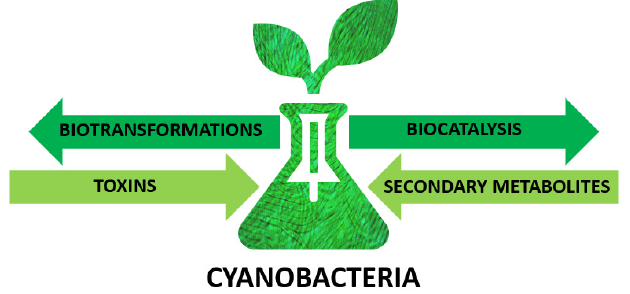
Figure 1. Selected applications of cyanobacteria.